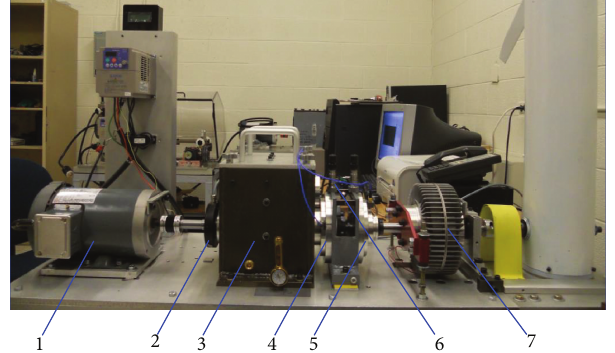
Figure 3: WT drivetrain test rig: (1) motor, (2) tachometer, (3) fixed-shaft gearbox, (4) planetary gearbox stage 1, (5) planetary gearbox stage 2, (6) accelerometers, and (7) loading device.